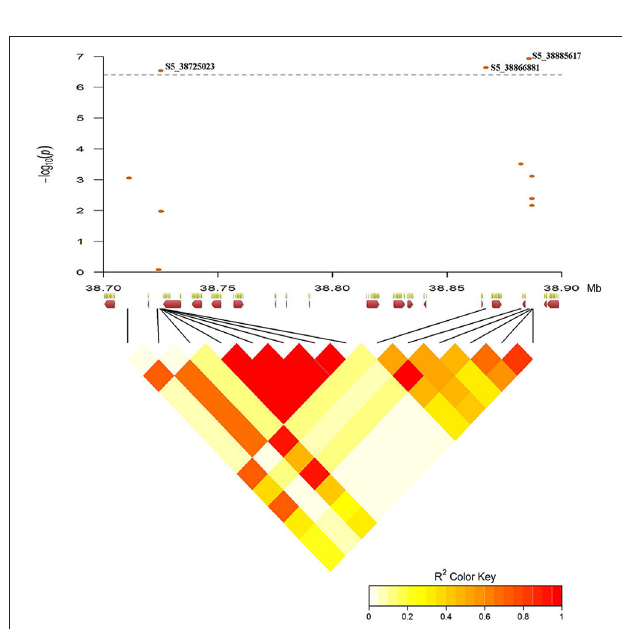
FIGURE 10 | Pairwise linkage disequilibrium between significant SNP markers from GWAS defining HB5.1 QTL region on Pv05 was generated using the LDheatmap package in R v3.2. The x-axis depicts the 13 candidate genes (red arrows, Table S9) within the 162-kb region.